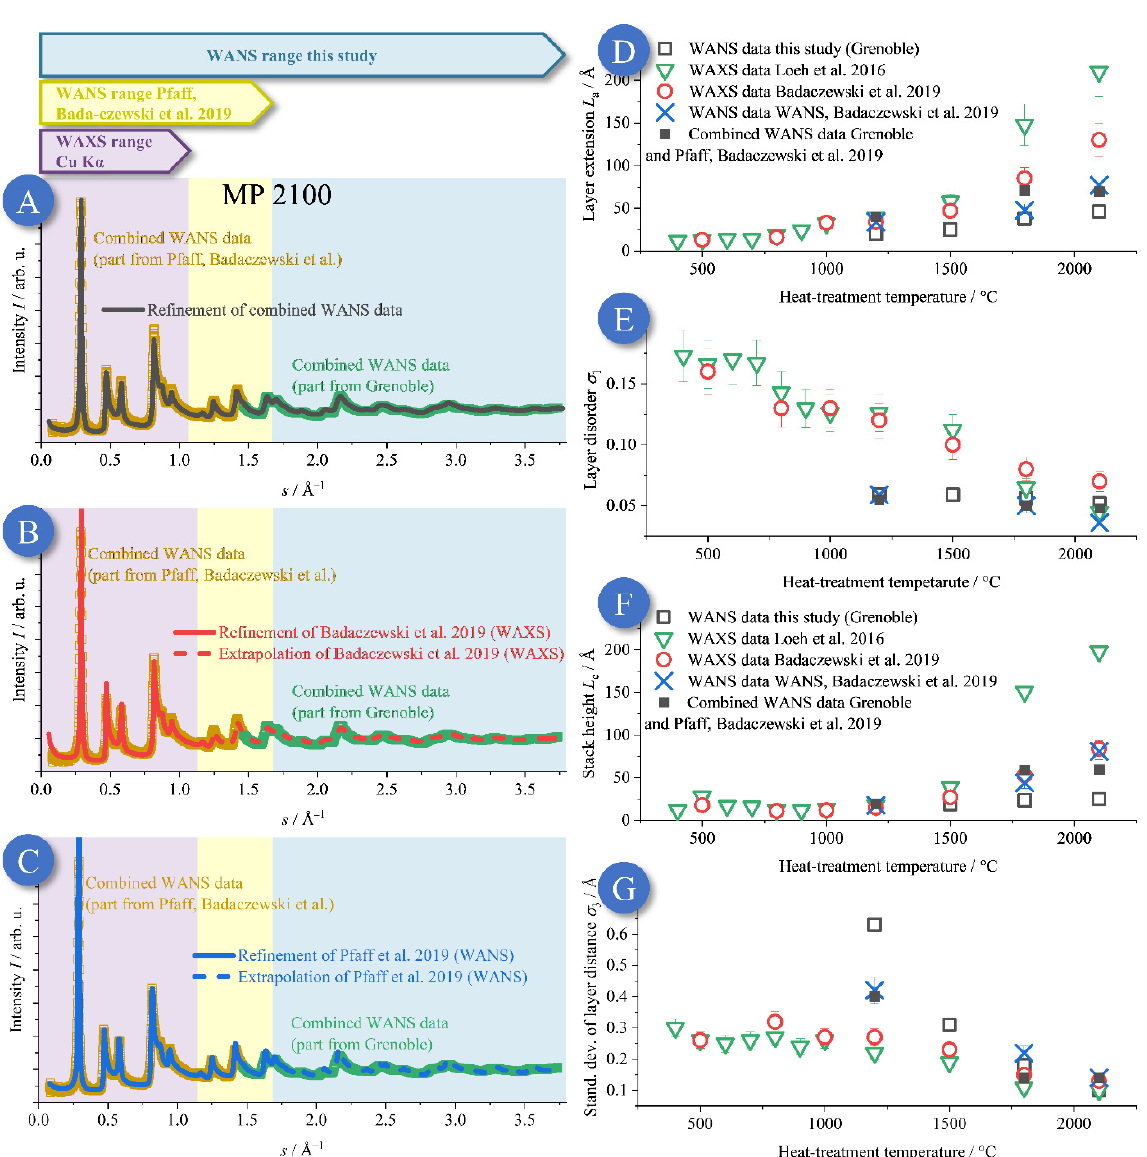
Figure 10. ( A – C ): Comparison of the mesophase pitch temperature series between the present WANS study, WAXS analysis of Badaczewski et al. [37], and WANS data from Pfaff et al. [43]. There are signif- icant differences between the fits of this study (black border only) and the simulation using the WAXS results from Loeh et al. [40] (2016), Badaczewski et al. [37] (2019) and the WANS results from